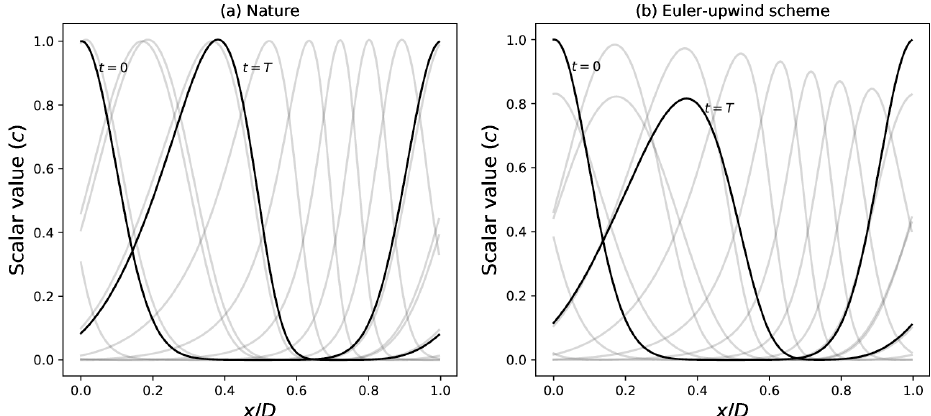
Figure 3. Nature (a) and numerical model (b) runs for times from t = 0 to t = T and represented each 0 . 1 T